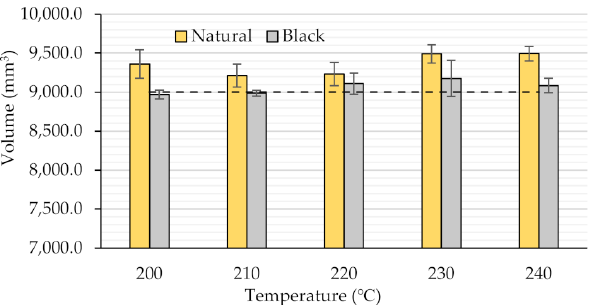
Figure 1. The variation of the volume (prismatic specimen with theoretical volume: 9000 mm 3 , dashed line) with the printing temperature and the filament